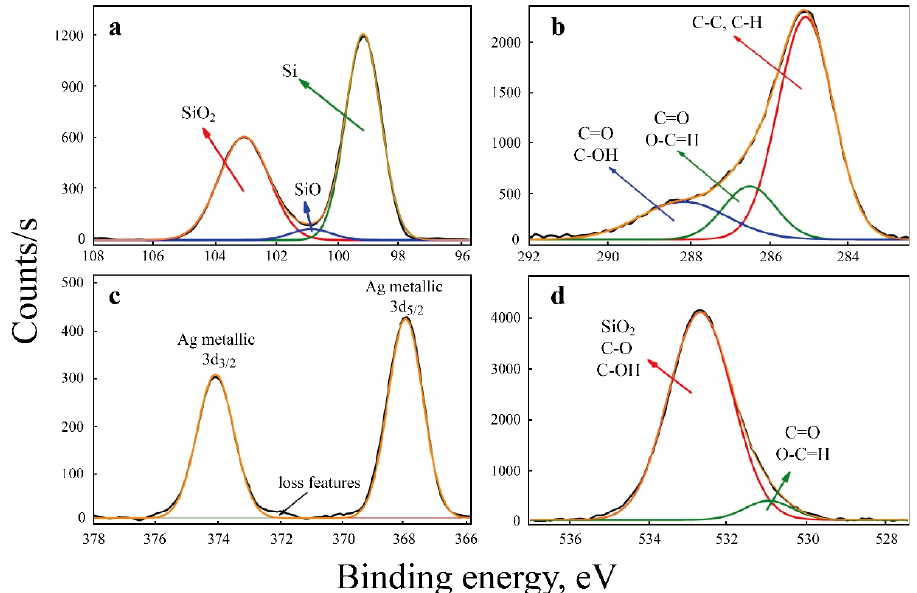
Figure 3. XPS spectra of ( a ) Si2p, ( b ) C1s, ( c ) Ag3d and ( d ) O1s for AgNPs deposited by ALD on the surface of c-Si.